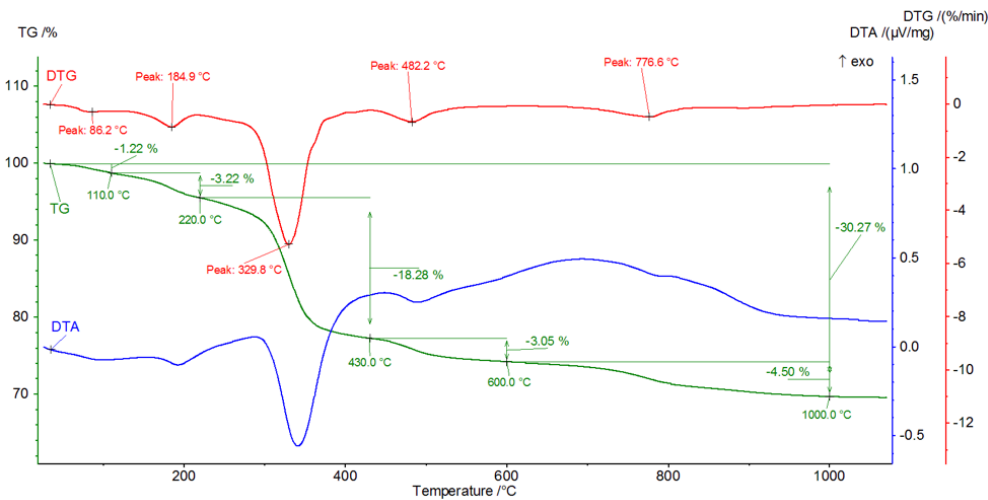
Figure 10. H 2 O and CO 2 release curves from sample W as ionic current as a function of temperature.